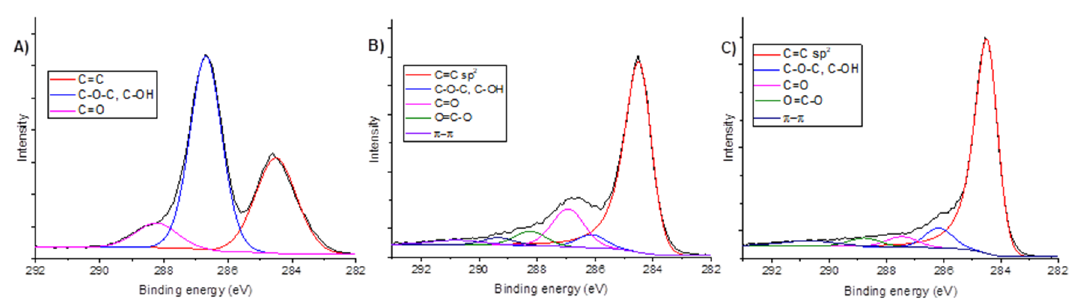
Figure 3. The C1s XPS spectra of the GO-lf ( A ), rGO-lr ( B ), and rGO-hr ( C ) samples. The deconvoluted spectra demonstrate changes in the amount of adequate oxide groups of GO after reduction ( B,C ).